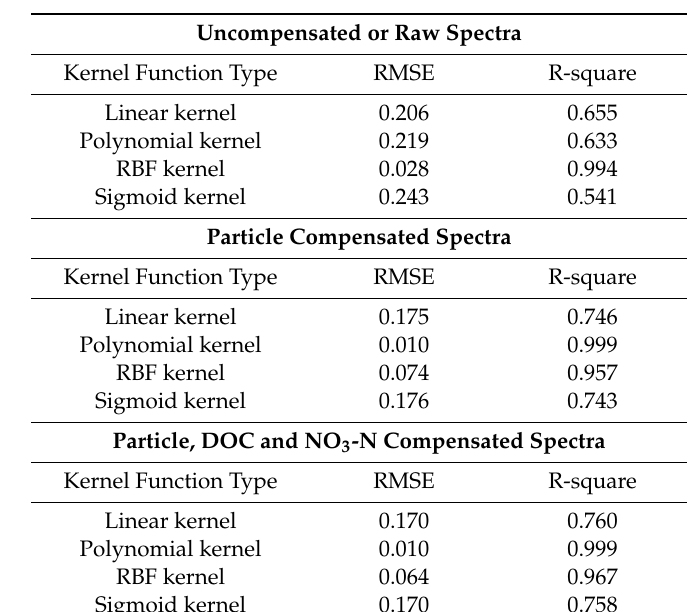
Table A2. SVR modelling performance in terms of RMSE and R-square for di ff erent kernel functions in model training.